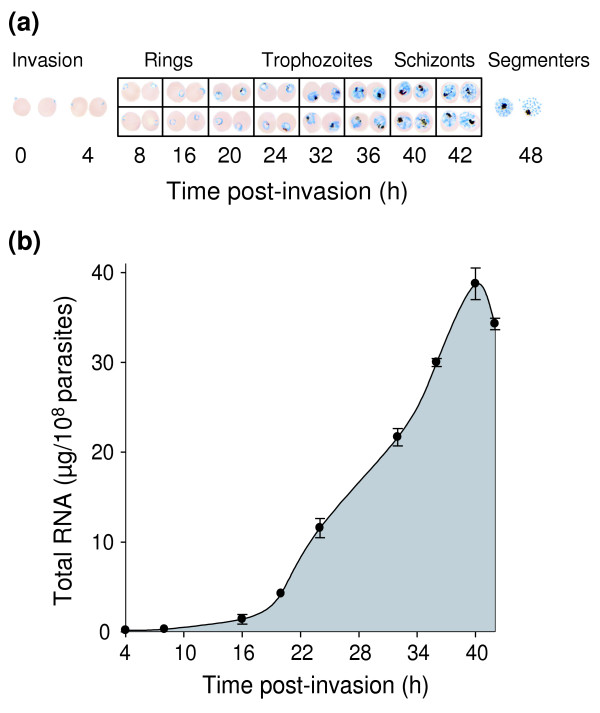
RNA obtained at different stages of P. falciparum development in the erythrocyte. (a) Representative Giemsa-stained P. falciparum-infected erythrocytes at the growth stages analyzed in this study. Samples from a tightly synchronized P. falciparum FAF6 culture were collected for the extraction of total RNA at ring (~4, 8, 16 and 20 h post-invasion), trophozoite (24, 32 and 36 h post-invasion) and schizont stages (40 and 42 h post-invasion). The cells depicted show the morphology of the parasitized cells in the culture at the given time point. The amount of RNA yielded from parasite cultures at around 4 h post-invasion was too low to warrant the inclusion of this time point in the subsequent gene-expression studies. Cells in the top row of boxes are from the first time course; cells in the bottom row are from the repeat time course (performed approximately 4 months later). (b) The quantity of total RNA inside the parasitized cell increases dramatically over the intraerythrocytic cycle. Total RNA was extracted from tightly synchronized P. falciparum FAF6 culture samples collected at nine stages (see above) over a single 48-h growth cycle of the intraerythrocytic parasite. The data are averaged from two different time courses performed approximately 4 months apart and are shown ± range/2.